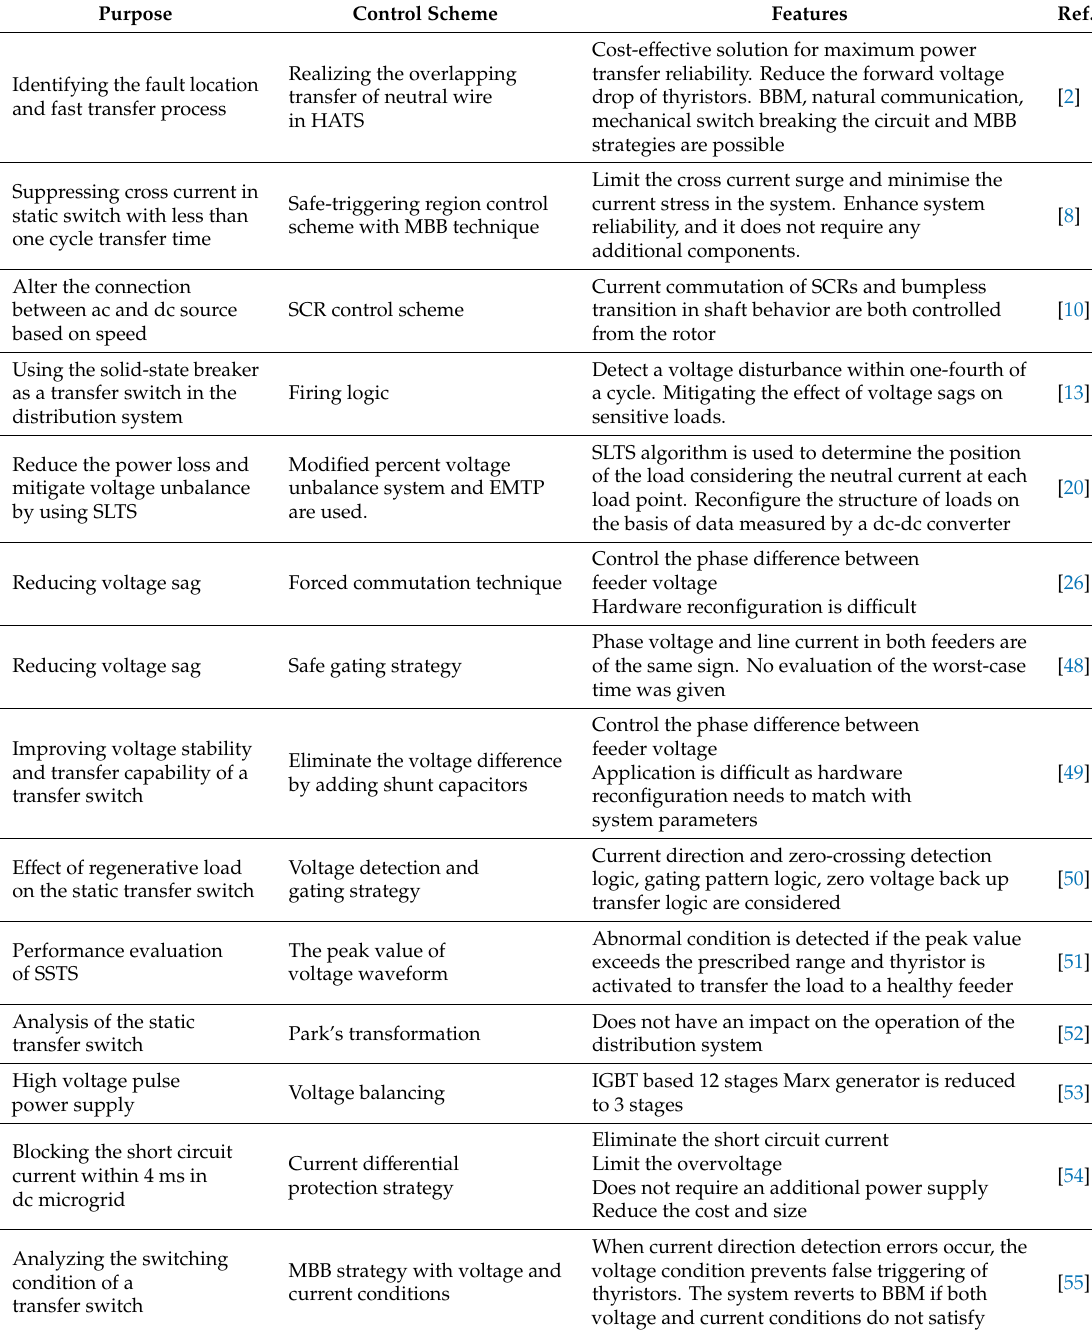
Table 5. Comprehensive review on SSTS control and switching